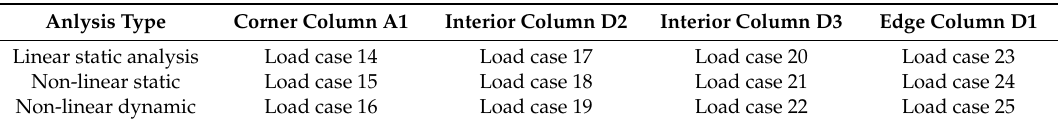
Table 6. Load cases to asses deformation-controlled actions when moment frames are used in building perimeterw and internally along grid lines B, C, D, E, F, and